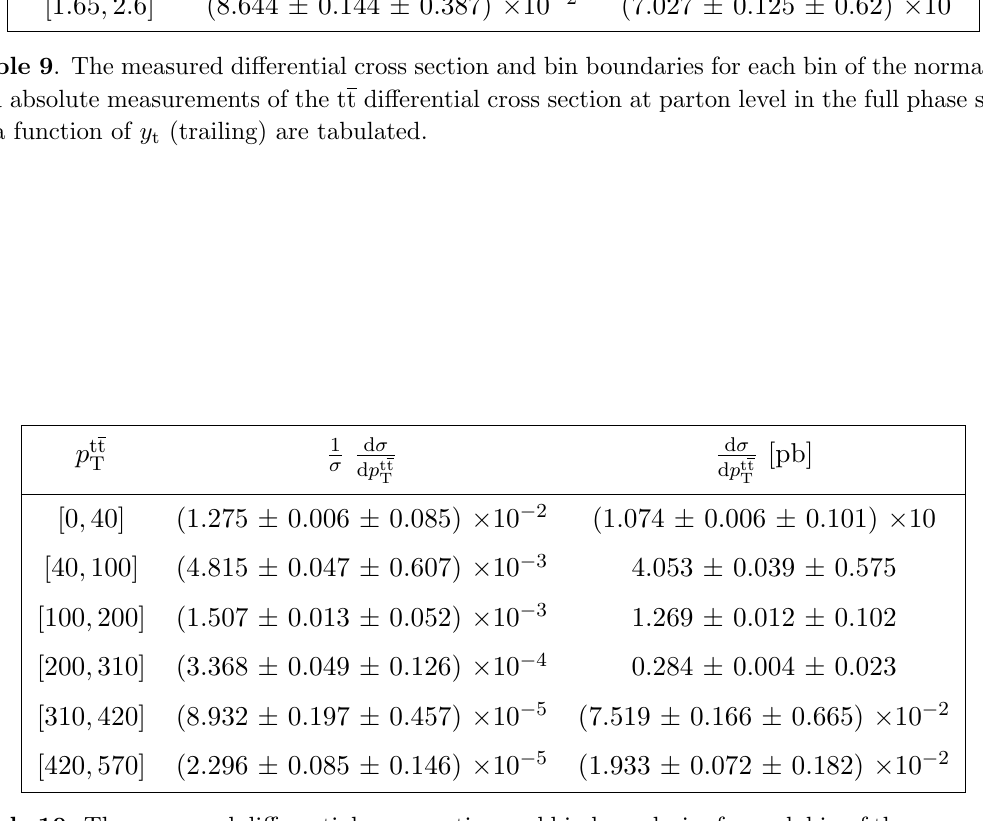
Table 10 . The measured di(cid:11)erential cross section and bin boundaries for each bin of the normalized and absolute measurements of the tt di(cid:11)erential cross section at parton level in the full phase space as a function of p tt are T